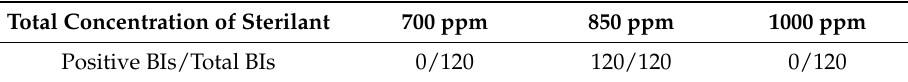
Figure 7. Survivors vs. VPHP (Vaporized Hydrogen Peroxide) Concentration. Table 3. Survivors vs. Total Concentration of H 2 O 2 .